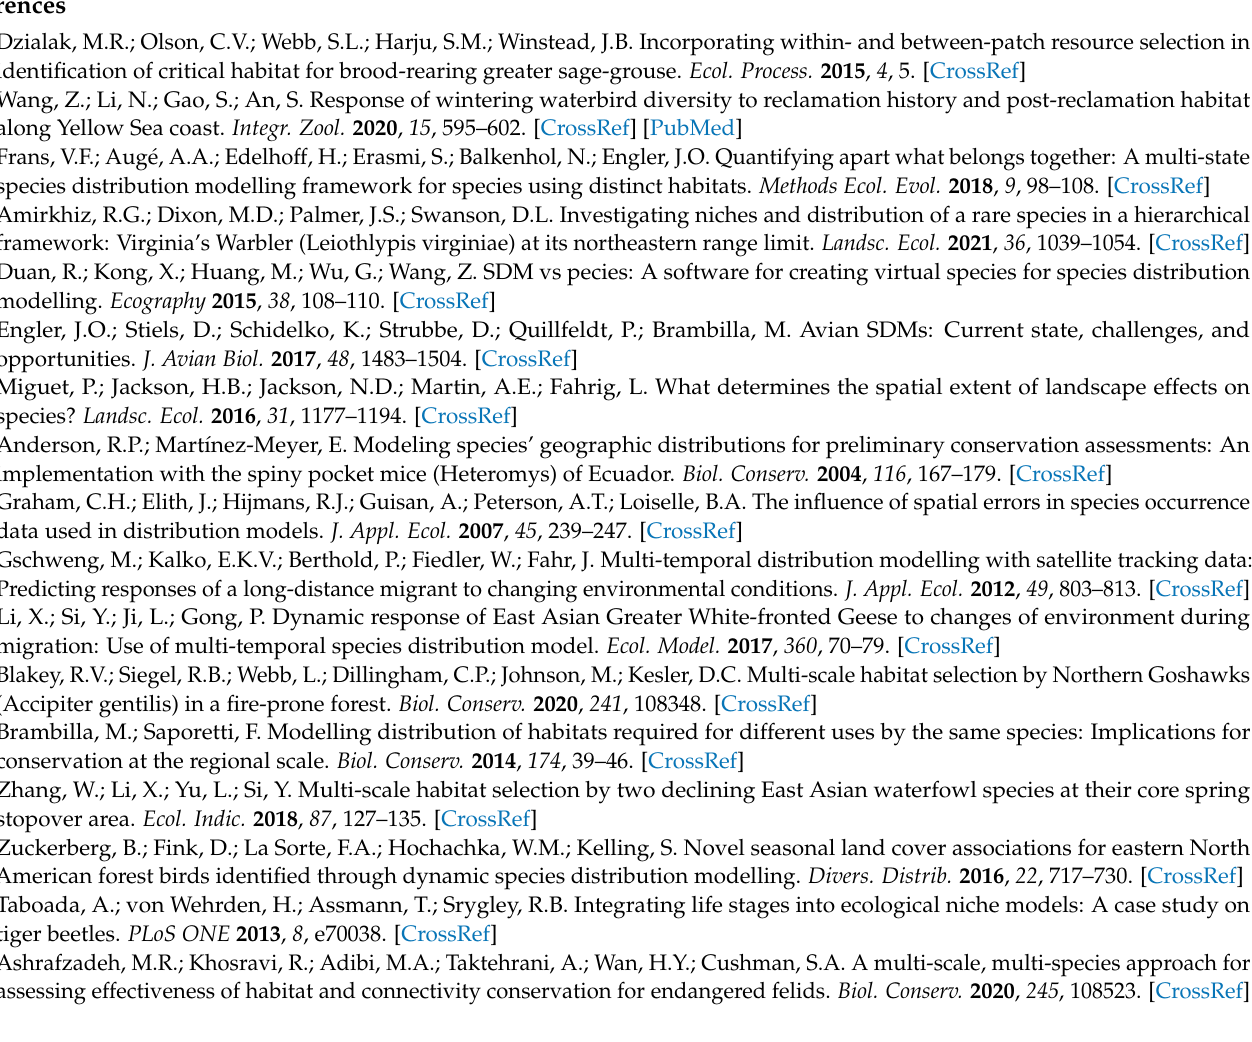
10.3390/rs13214397/s1, Figure S1: Correlation matrix of retained variables for final multi-scale habitat modeling of roosting state, Figure S2: Correlation matrix of retained variables for final multi-scale habitat modeling of foraging state, Table S1: AUC for optimized scale selection of the variables for foraging state, Table S2: AUC for optimized scale selection of the variables for roosting, Table S3: Component models with ∆ AICc < 2 of the top ranked models for foraging, Table S4: Component models with ∆ AICc < 2 of the top ranked models for